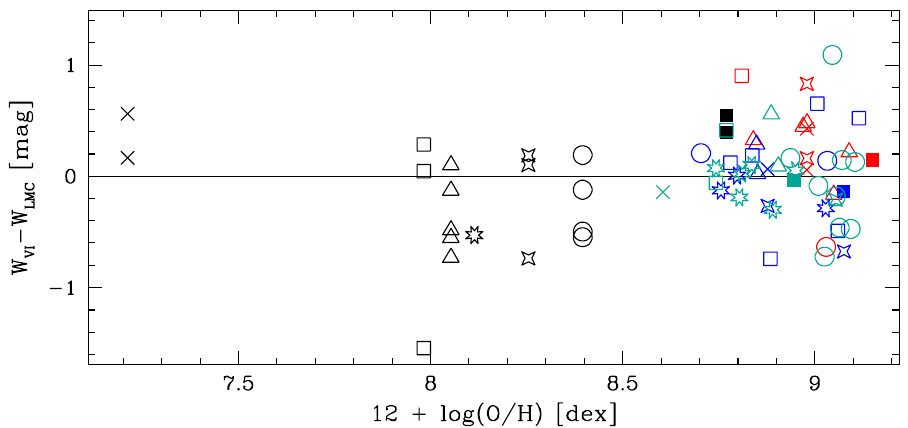
Figure 3. The differences between the observational Wesenheit of the ULPs, W VI , and that obtained adopting the OGLE relation [21], W LMC , are plotted as a function of the host galaxy distance modulus (upper panel) and metallicity (lower panel), respectively. The adopted symbols for the ULPs are the same as in Figure